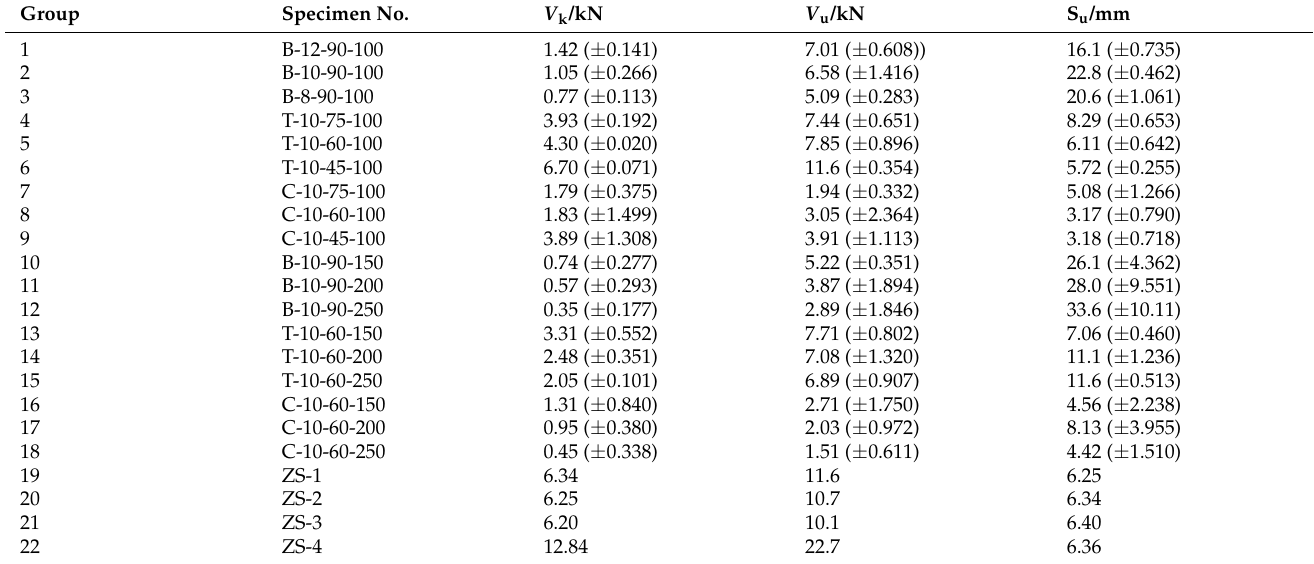
Table 3. Load capacity and corresponding displacement.